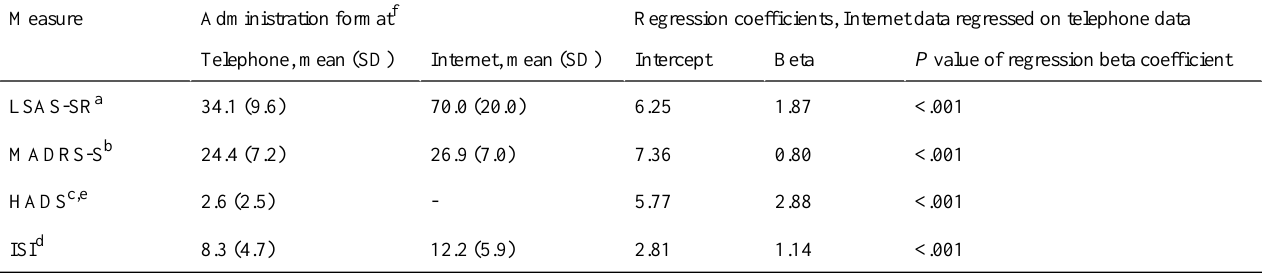
Table 3. Mean, SD, and regression coefficients to predict Internet self-report from telephone